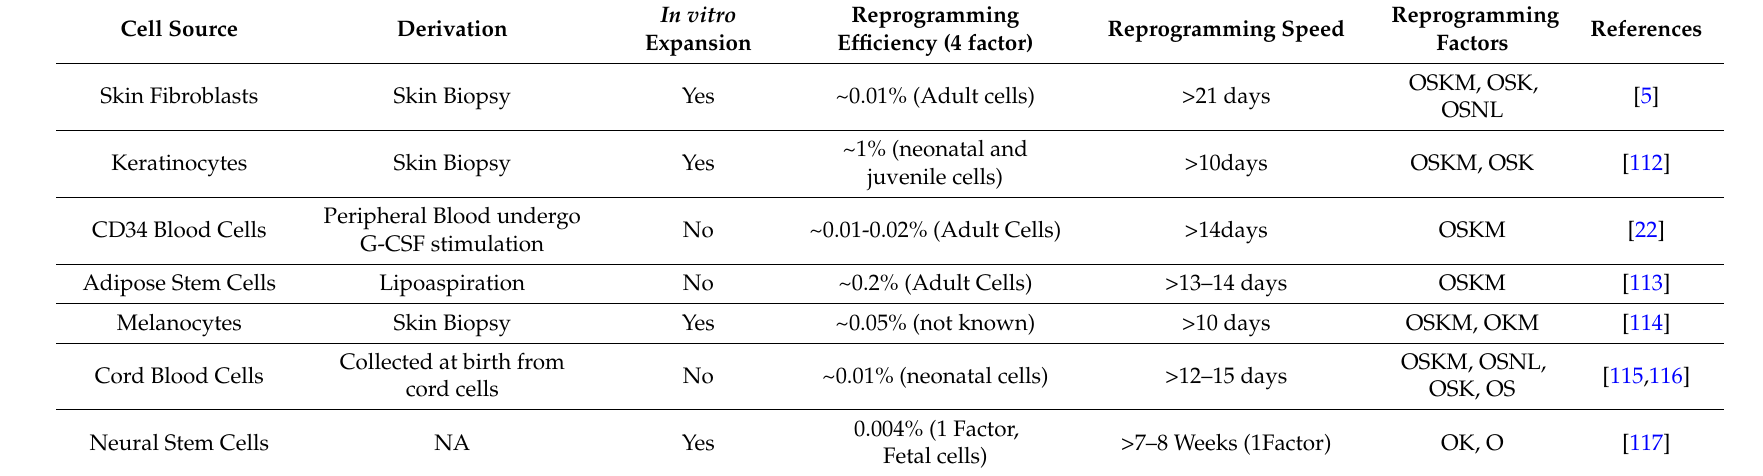
Table 1. Comparison of different cell origins used for reprogramming